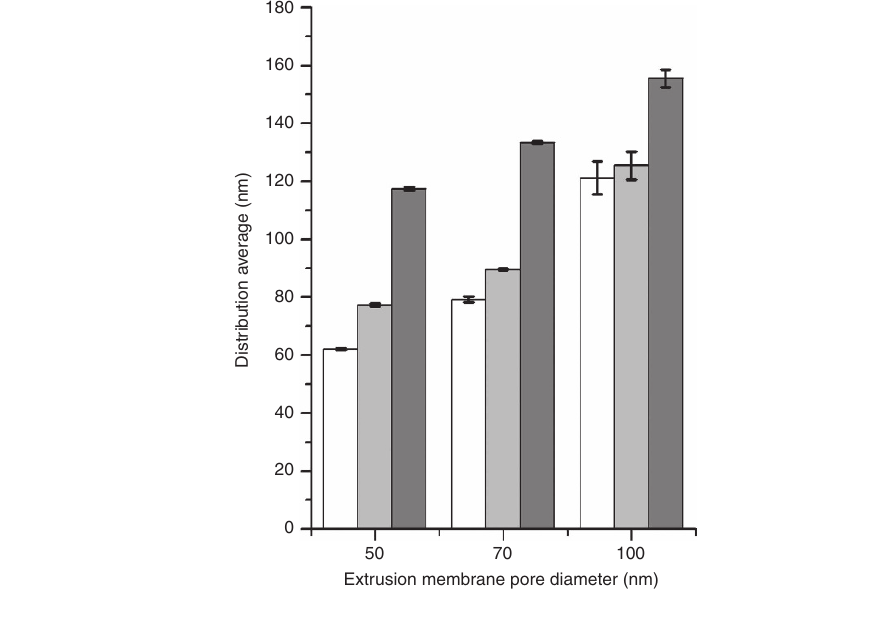
NATURE COMMUNICATIONS|8:15667|DOI: